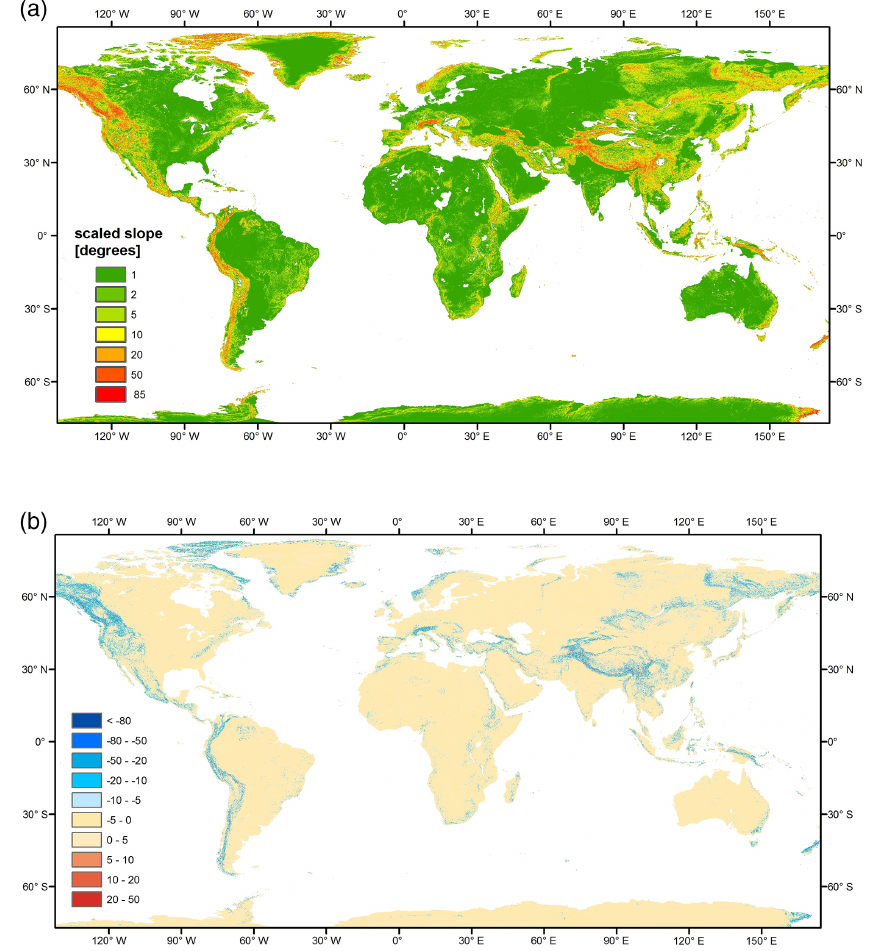
Figure 2. (a) A global map of the scaled slope derived from the 30arcsec DEM using a target resolution of 150m. (b) A global map showing the difference between the unscaled and scaled slopes (in degrees), where blue colours show an underestimation by the unscaled slope when compared to the scaled slope and reddish colours show and